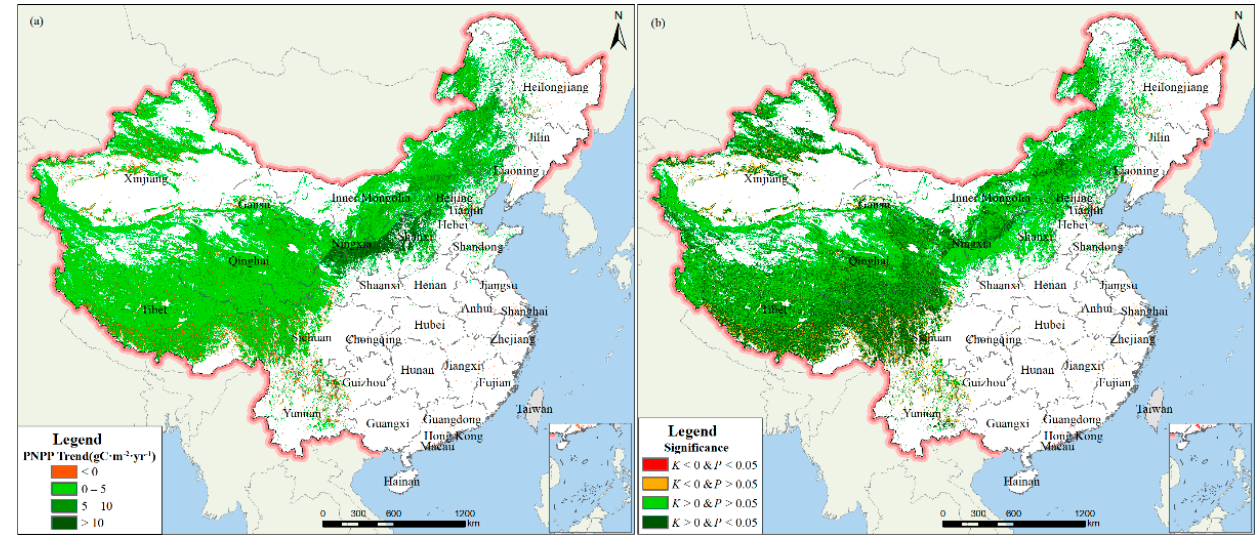
Figure 8. ( a ) Trend in PNPP (2001–2020) and ( b ) the significance levels. (Note: K is the change trend of ANPP, and P is the significance levels).